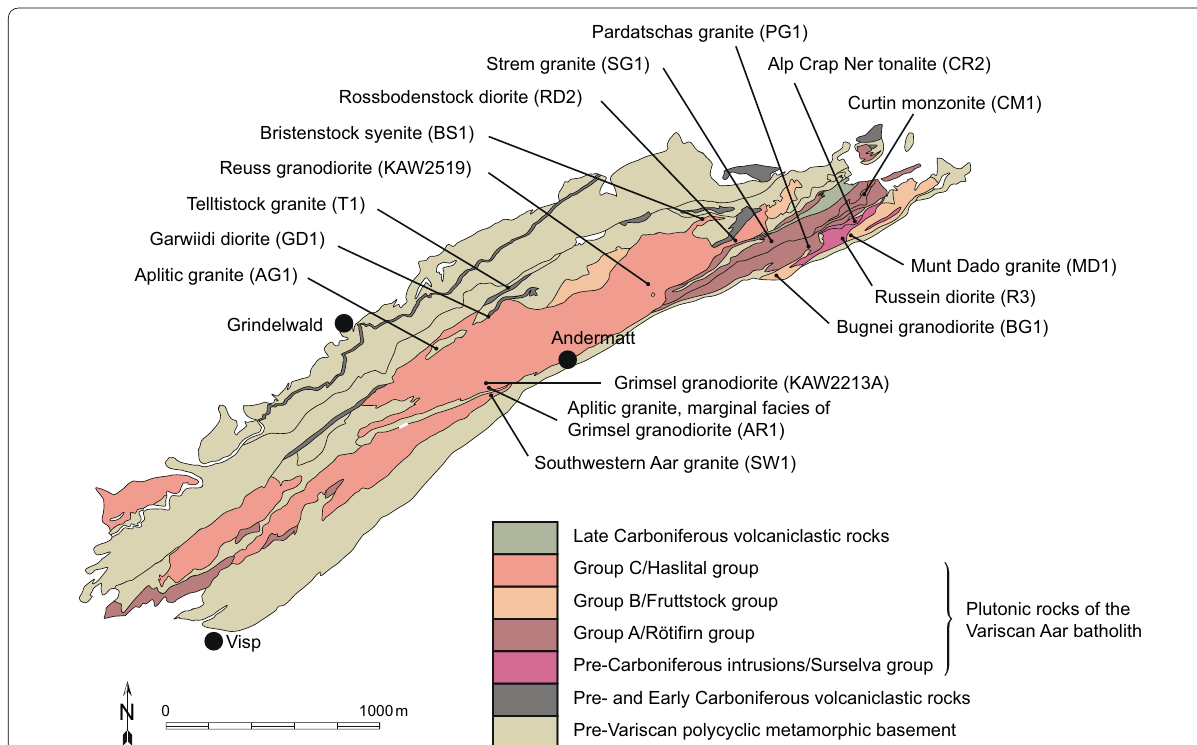
Fig. 1 Geological sketch map of the Aar massif with the areal distribution of the four main groups of intrusive rocks of the Variscan Aar batholith (modified from Berger et al.,